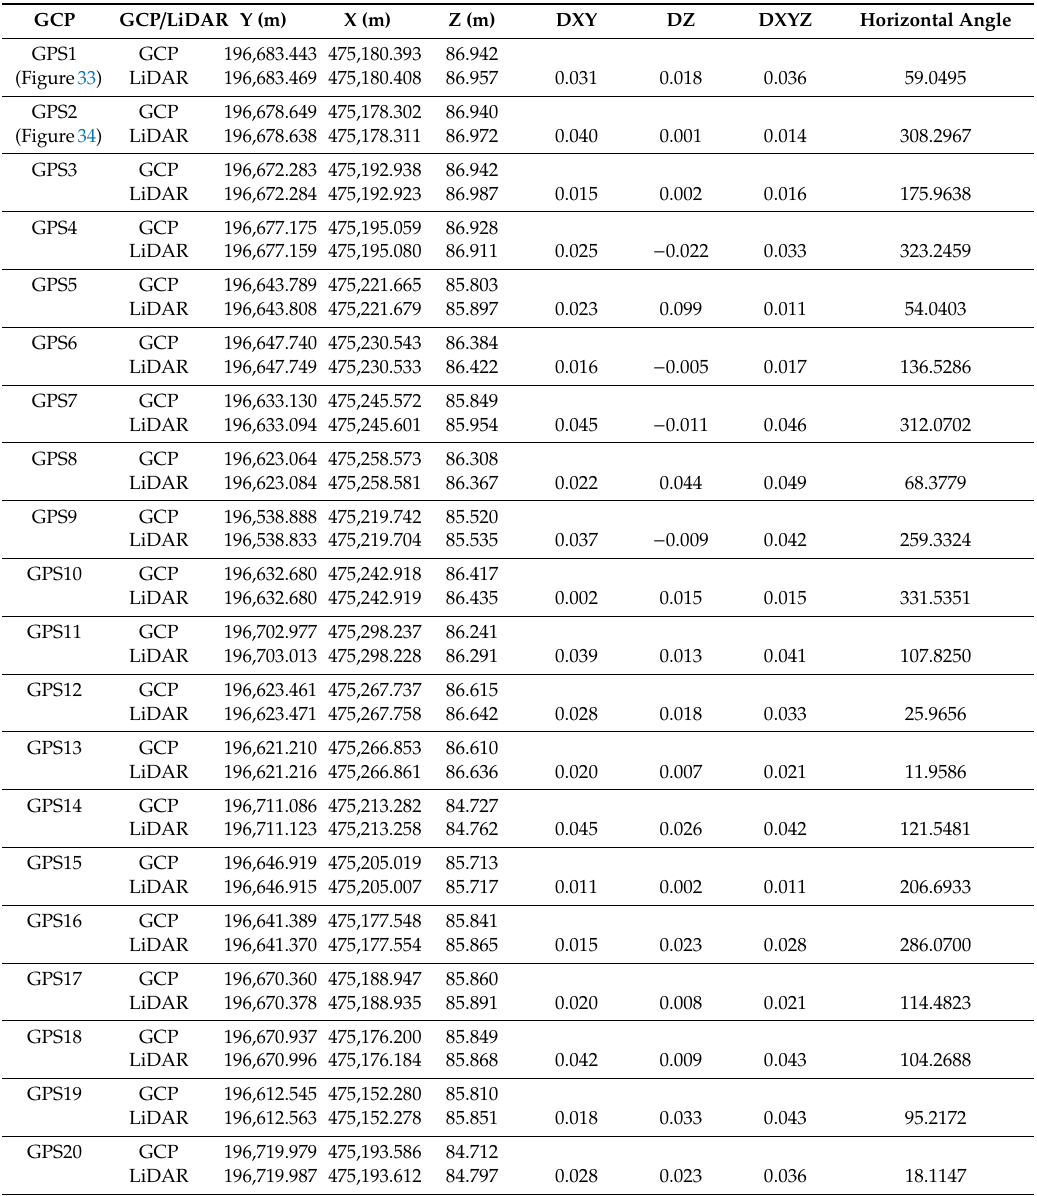
Table 5. Absolut scanning accuracy by verifying LiDAR 3D cloud point over the GCPs for S â nmihaiu Rom â n